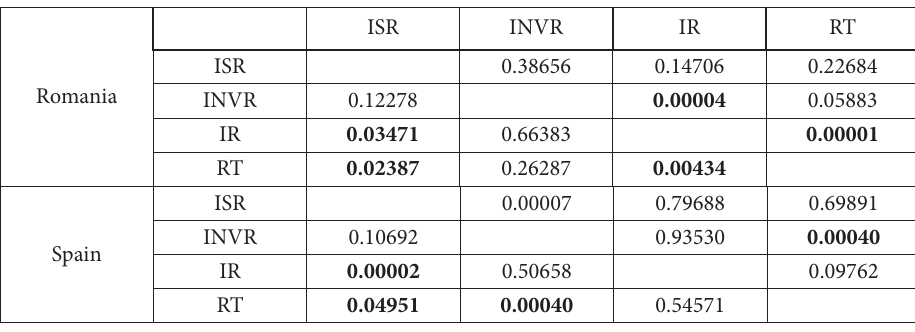
Table 4. Granger causality